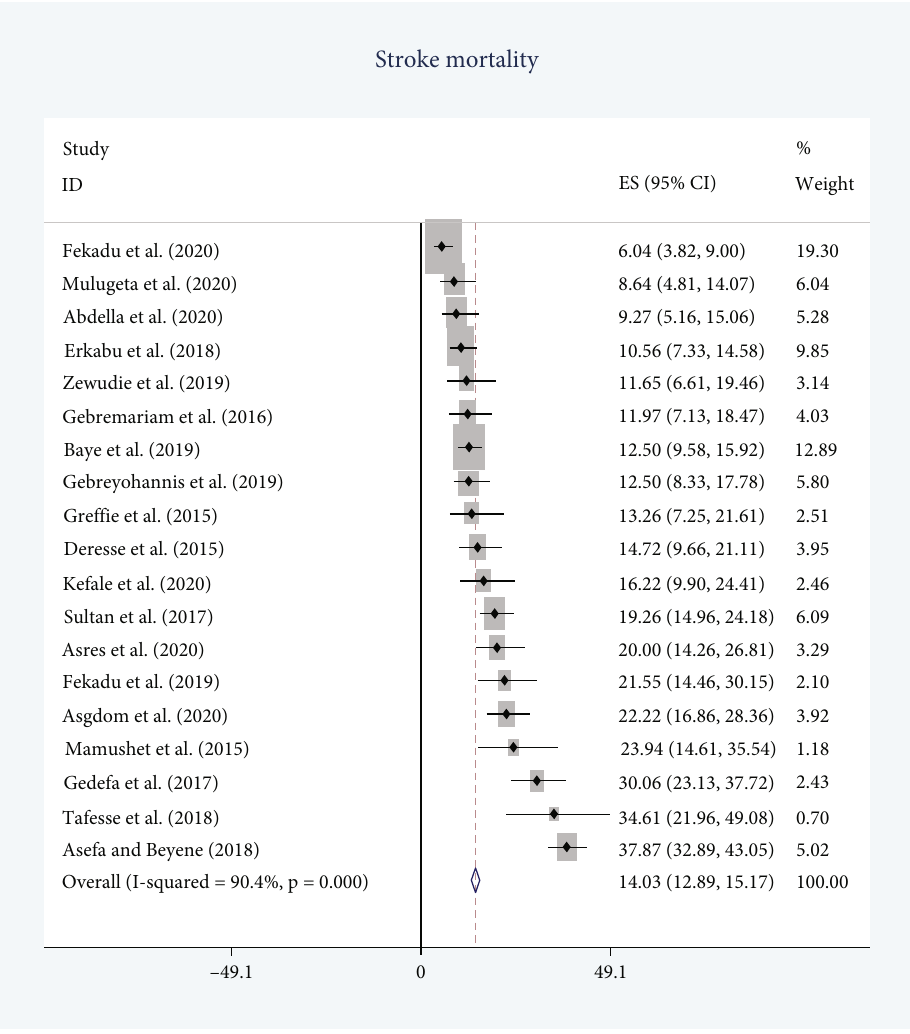
Figure 2: Forest plot of pooled in-hospital stroke